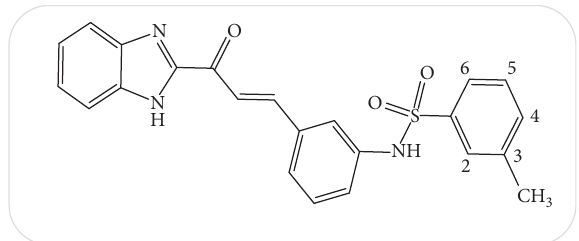
Figure 6: The structure of the most active molecule (17) used in the contour